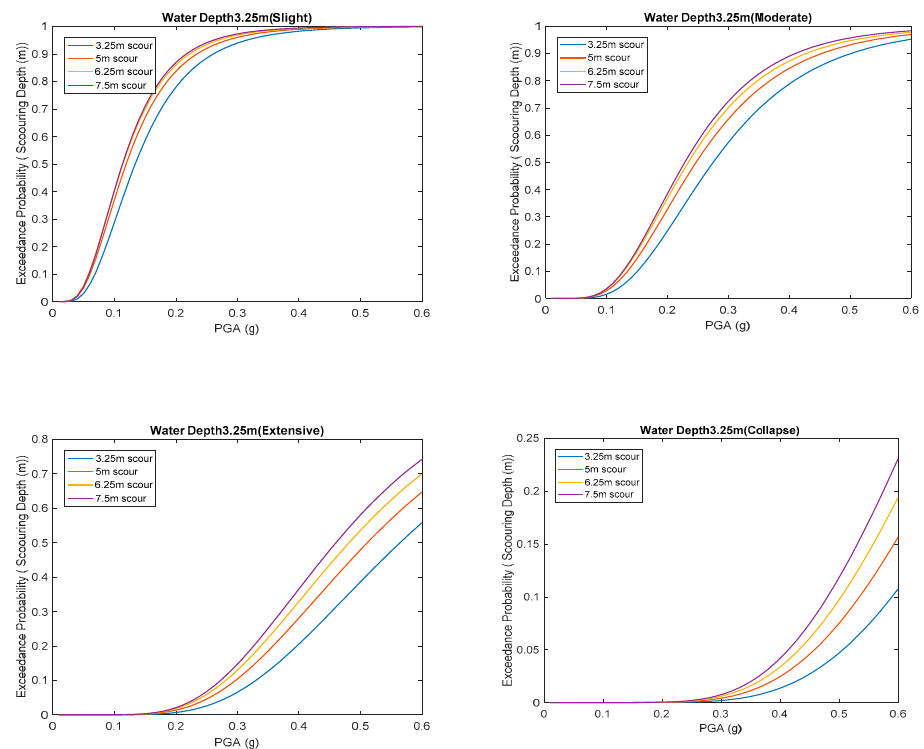
Figure 19. Fragility curves of each scoring depth under the same water level and same performance level using LSSVM.